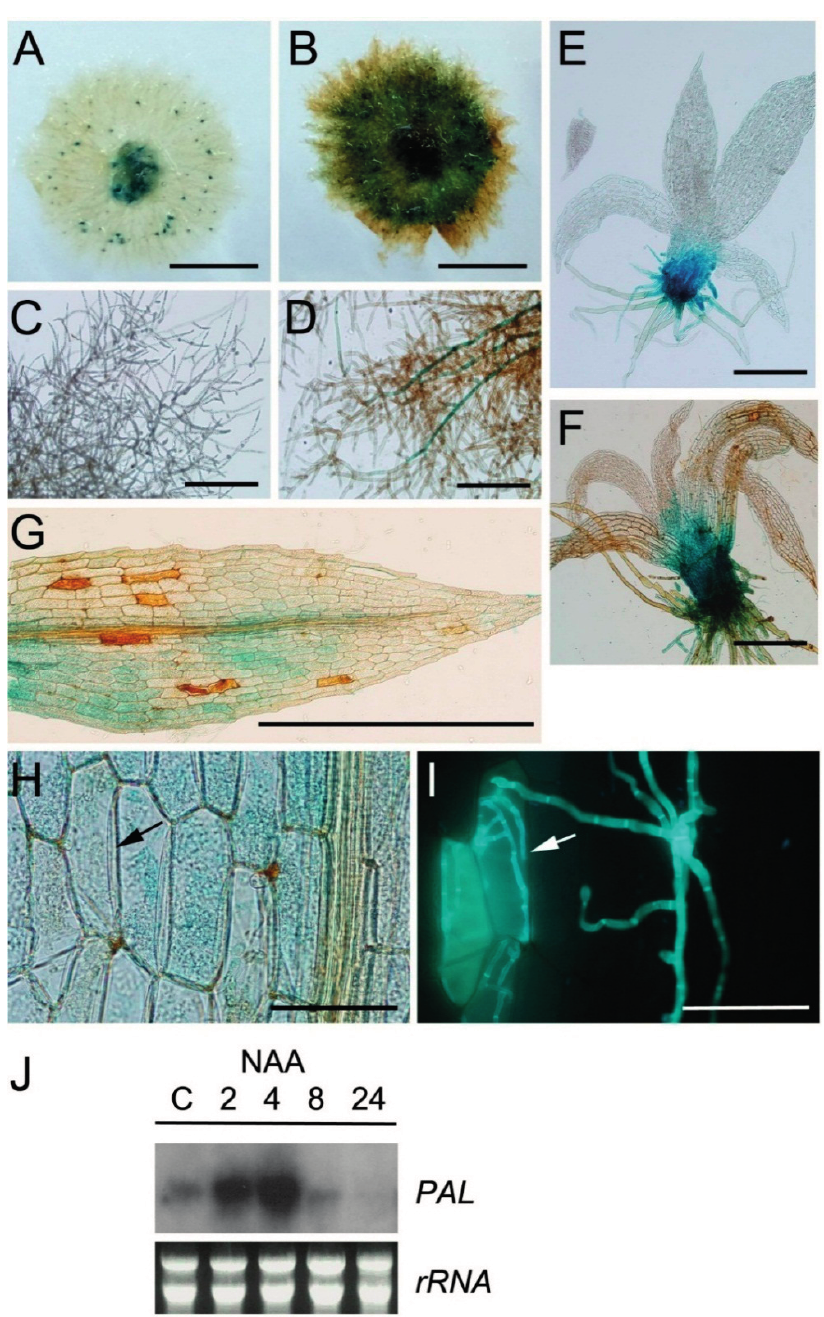
Figure 6. Auxin signaling is activated in P. patens after C. gloeosporioides inoculation. GUS staining of GH3::GUS reporter line in: ( A ) Untreated colony; ( B ) C. gloeosporioides -inoculated colony; ( C ) Untreated protonema; ( D ) C. gloeosporioides -inoculated protonema; ( E ) Untreated gametophore; ( F ) C. gloeosporioides -inoculated gametophore; ( G ) C. gloeosporioides -infected leaf; ( H ) C. gloeosporioides -infected leaf; ( I ) Same leaf as H stained with solophenyl. The black arrow in H and the white arrow in I indicate C. gloeosporioides -infected cells. All pictures of C. gloeosporioides inoculated tissues were taken at 2 DAI; ( J ) Expression of PAL after NAA treatment. Moss samples were harvested at the indicated times (hours) after treatment. Scale bars represent 0.5 cm in A and B ; 0.5 mm in C – G and 50 μ m in H and I